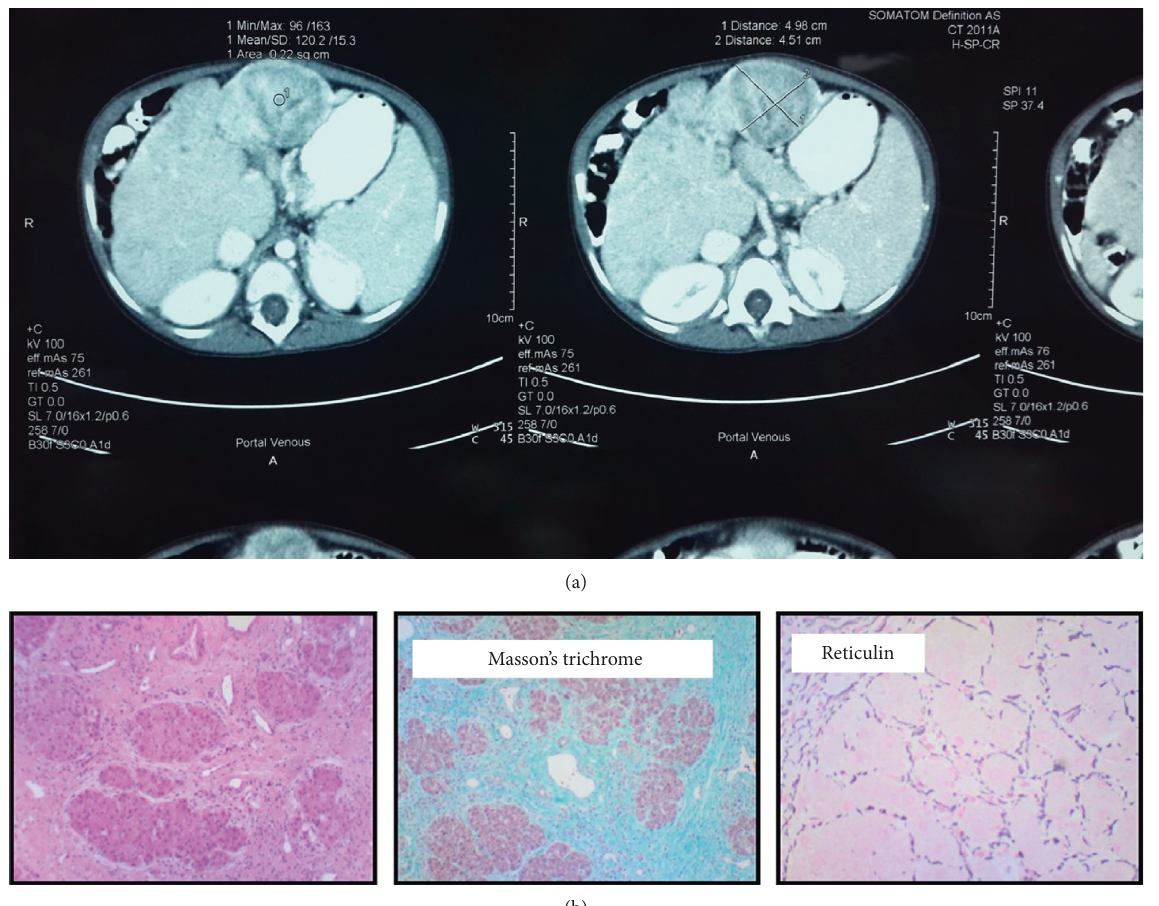
Figure 2: (a) CT scan of the abdomen. Note the hepatic hemangioma (crossed lines 1 and 2). (b) Liver histology. Left to right: Liver parenchyma is present which, although subcapsular, shows evidence of marked distortion of the normal architecture, with fibrosis present surrounding regenerative-type nodules. Masson trichome stain shows extensive interstitial fibrosis surrounding regenerative-type nodules, as can be appreciated on the microphotograph. Reticulin stain shows twinning of the cell plates, which can be appreciated on the